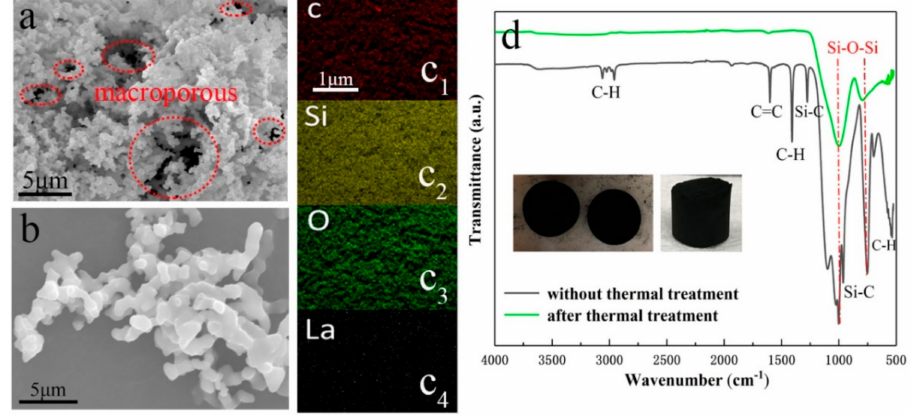
Figure 2. ( a – c ) SEM image and SEM–EDS elemental distribution maps of S3; ( d ) FTIR spectra of products (insert: thermally treated products at 800 ◦ C for 4 h in Ar